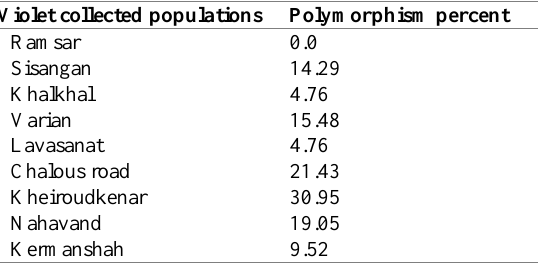
Table 8. Intra-population polymorphism percent of wild violet.